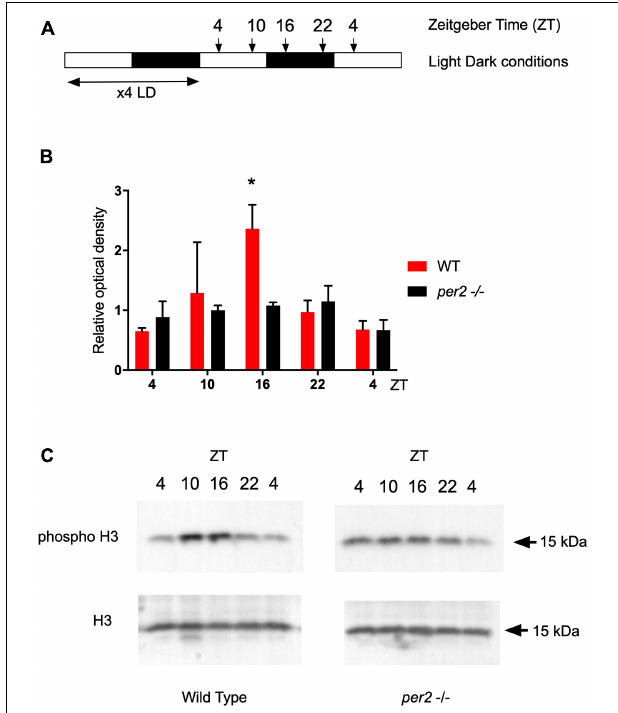
FIGURE 10 | Western blot analysis and quantification of the phospho-H3 protein in fins of the WT and per2 KO zebrafish line. (A) Schematic representation of the experimental design. (B) Quantification of Western blot analysis of Phospho-Histone H3 (p-H3) ser10 expression level normalized to using Histone H3 (H3) as loading control. Relative optical density values for pH3-specific bands were calculated from measurements of ECL images and plotted on the y -axis. (C) Representative images of western blots obtained with pH3 and H3 specific antibodies used for the quantification in panel (B) . Asterisks represent levels of significance in comparing the two genotypes at each timepoint individually, corrected by Sidak’s method (* p <